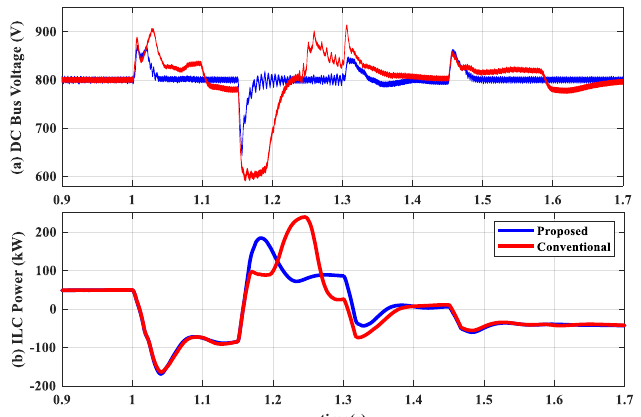
Figure21. Figure 21. System response to power generation variation in DER1 in Case II with BDC in voltage